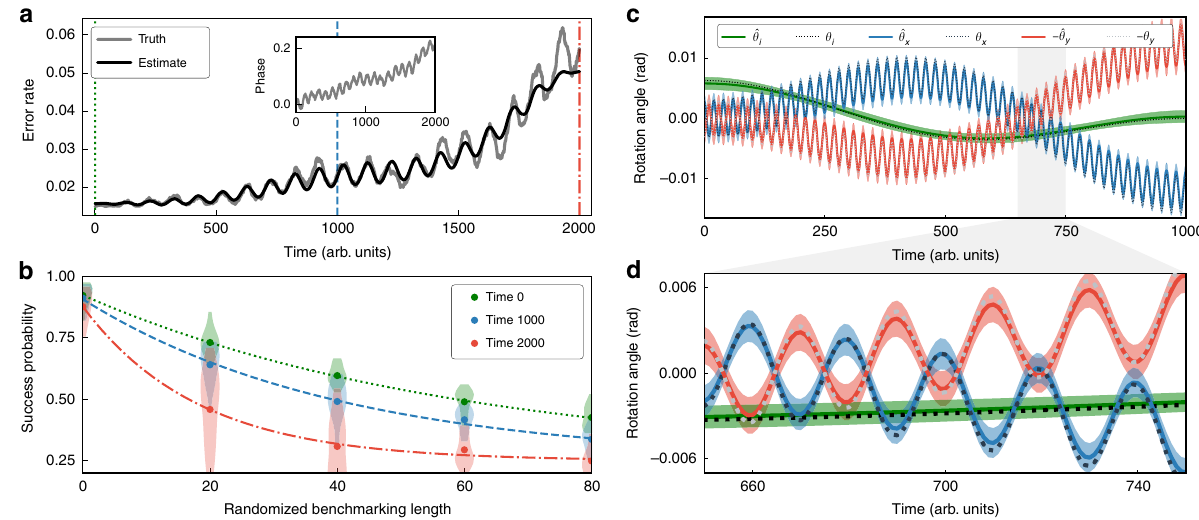
Fig. 2 Time-resolved benchmarking & tomography on simulated data. a , b Time-resolved RB on simulated data for gates with time-dependent phase errors. a Inset: the simulated phase error over time. Main plot: the true, time-dependent RB error rate ( r ) versus time (grey line) and a time-resolved estimate obtained by applying our techniques to simulated data (black line). b Instantaneous average-over-circuits (points) and per-circuit (distributions) success probabilities at each circuit length, estimated by applying our spectral analysis techniques to the simulated time-series data, and fi ts to an exponential (curves), for the three times denoted by the vertical lines in a . Each instantaneous estimate of r , shown in a , is a rescaling of the decay rate of the exponential fi t at that time. c , d Time-resolved GST on simulated data, for three gates G i , G x , and G y that are subject to time-dependent coherent errors around the ^ z , ^ x , and ^ y axes, respectively, by angles θ i , θ x , and θ y . The estimates of these rotation angles (denoted ^ θ i , ^ θ x and ^ θ y ) track the true values closely. The shaded areas are 2 σ (~95%) con fi dence